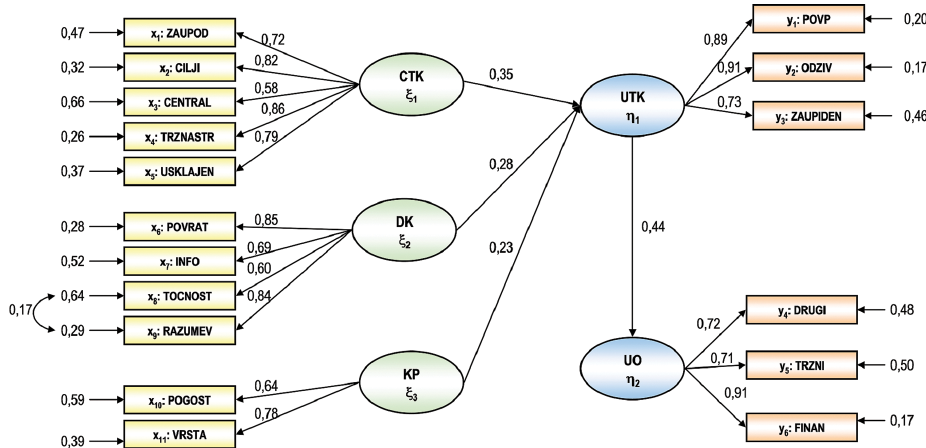
Fig. 1. Path diagram for the model of marketing communications effectiveness in the business-to-business